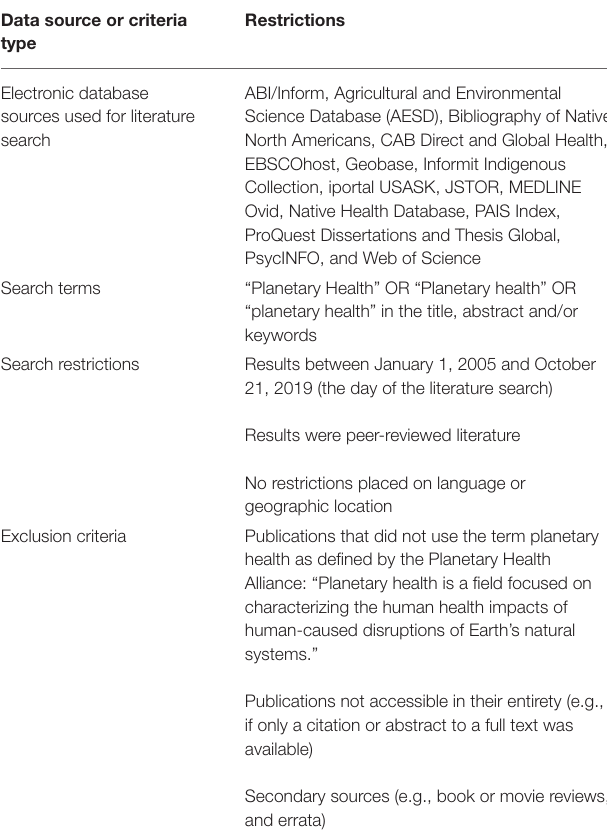
TABLE 1 | Data sources and criteria of the literature search used for the scoping review and bibliometric analysis of the planetary health